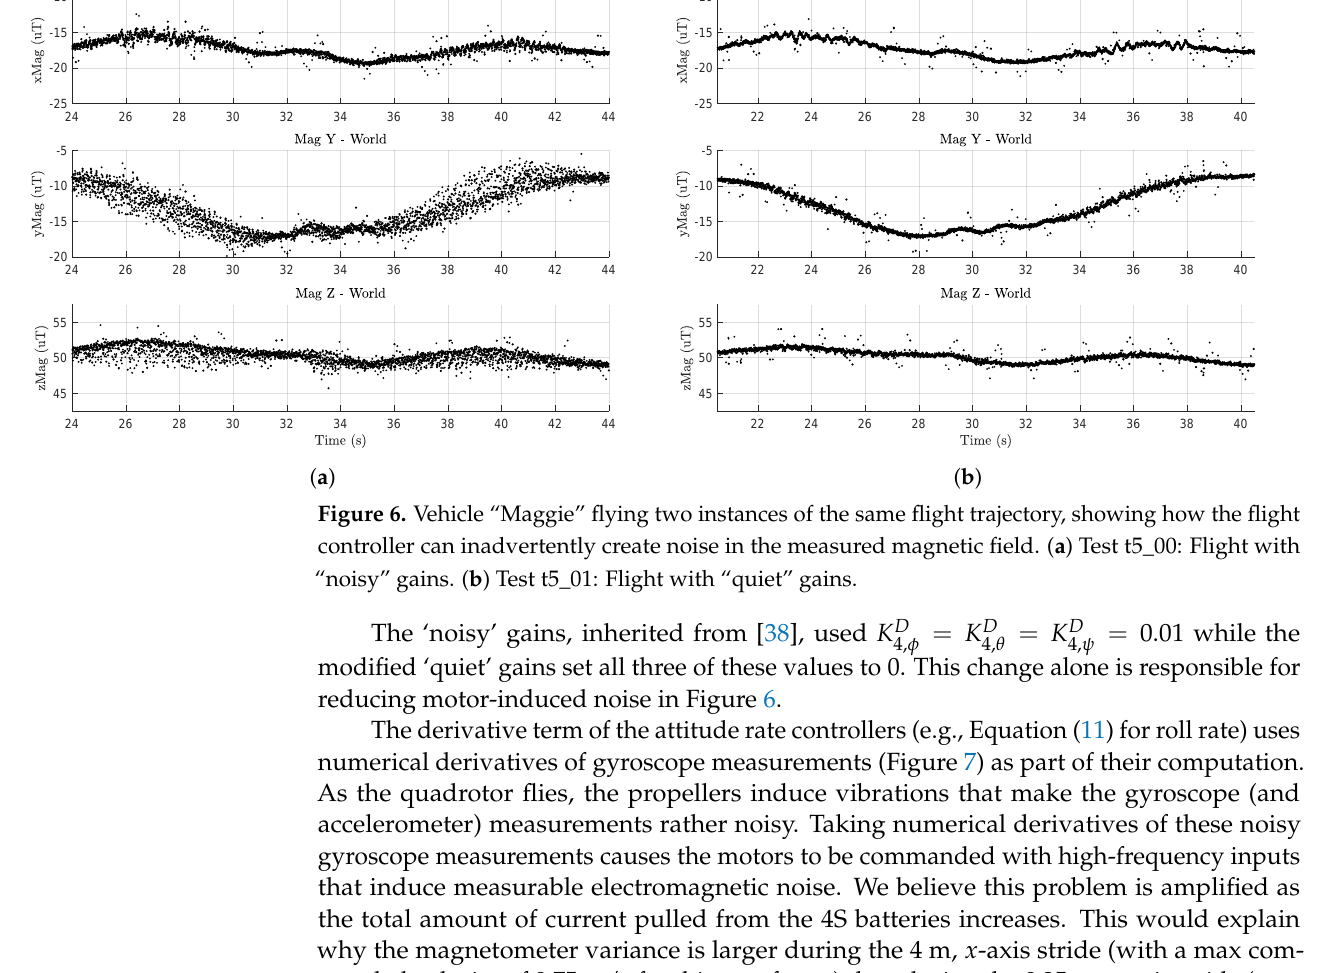
( ˙ ψ ) rates, respectively.